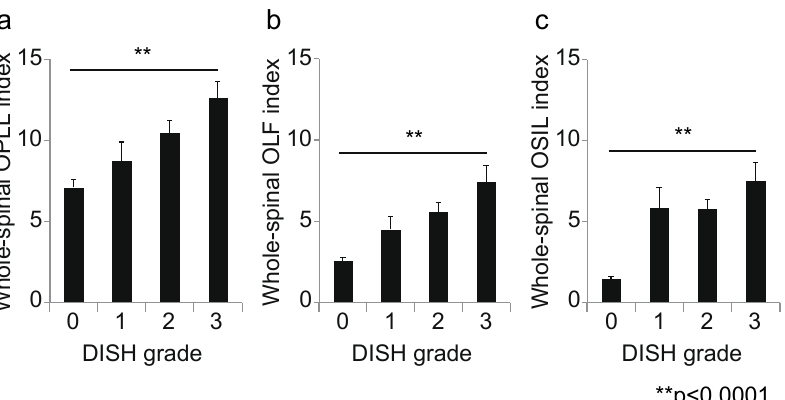
Figure 6. Correlation between DISH grade and OSL in the whole spine. ( a ) Whole-spine OPLL index; ( b ) whole-spine OLF index; ( c ) whole-spine OSIL index. DISH, diffuse idiopathic skeletal hy- perostosis; OLF, ossification of the ligamentum flavum; OPLL, ossification of the posterior longitu- dinal ligament; OSIL, ossification of the supra/interspinous ligaments; OSL, ossification of the spinal ligaments.